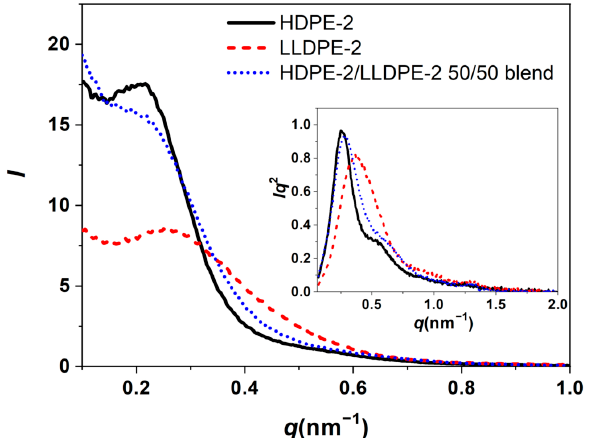
Figure 12. Linear and Lorentz-corrected scattering profiles of the neat HDPE-2, LLDPE-2, and the HDPE-2/LLDPE-2 50/50 blend.